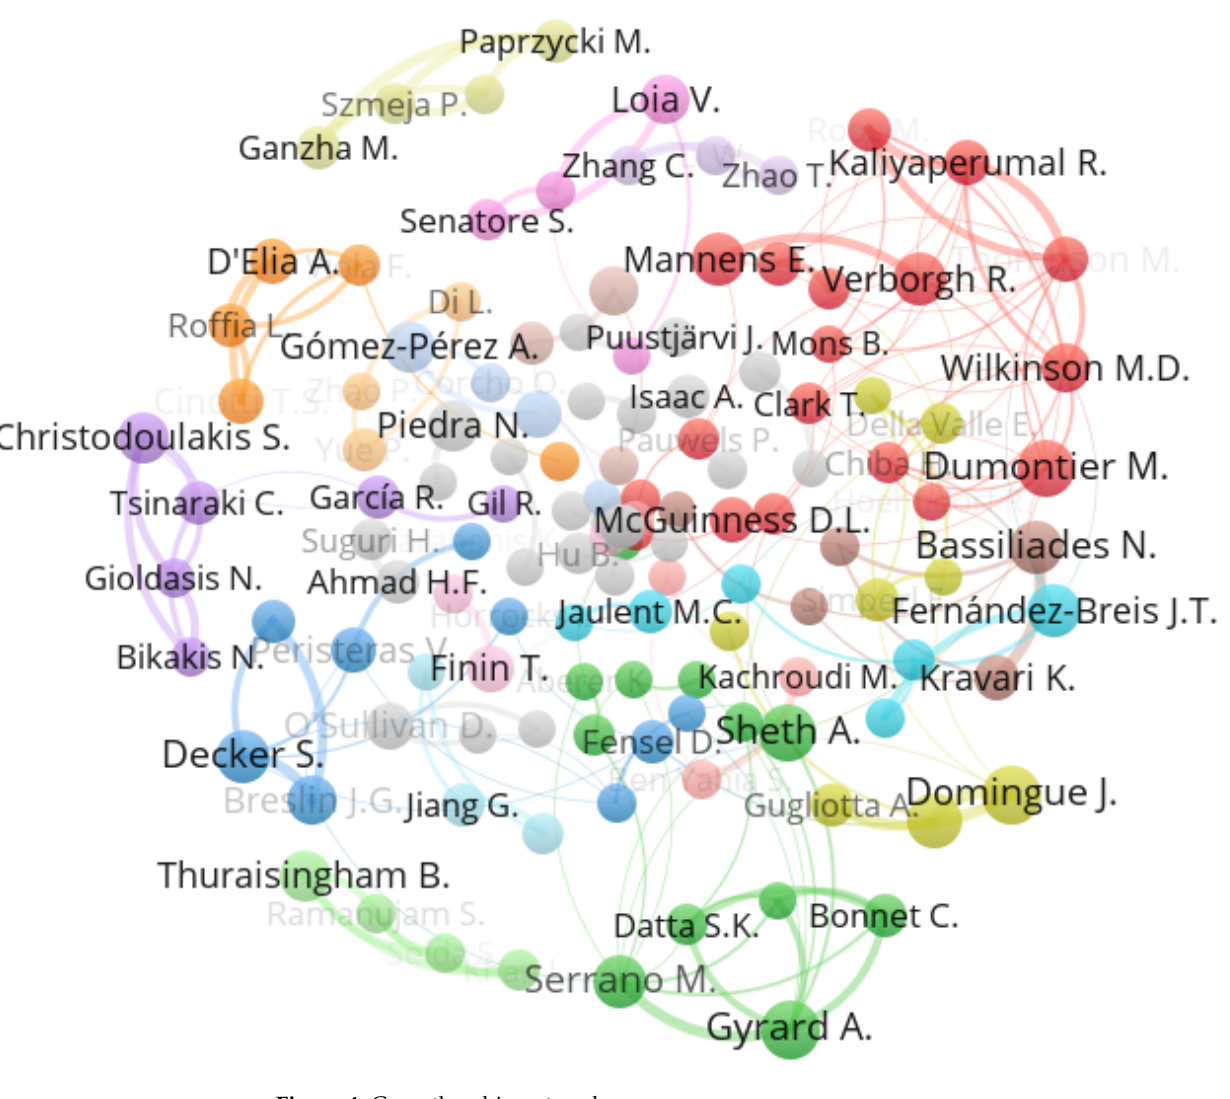
Figure 4. Co-authorship network. Table 6. Top 20 most frequent keywords.